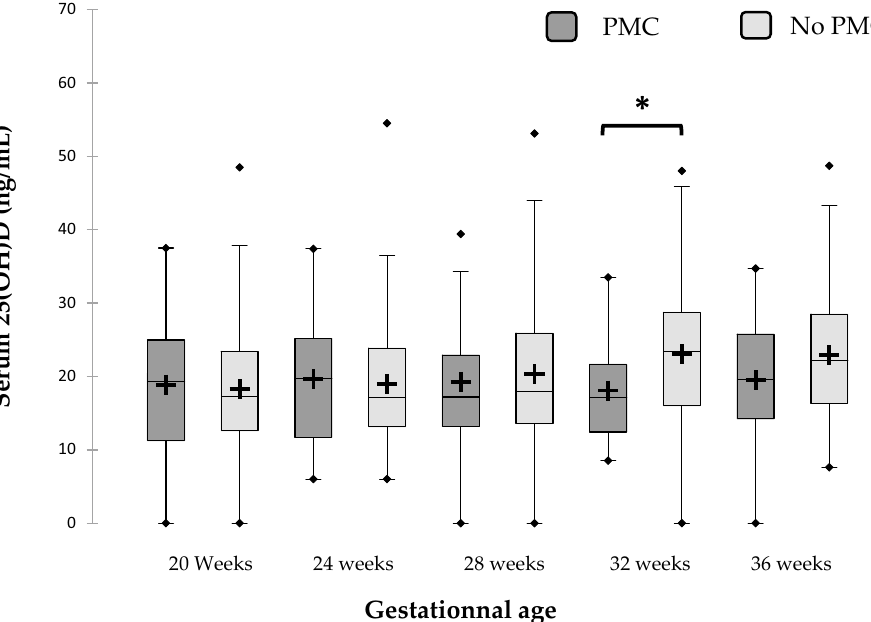
Figure 1. Evolution of the vitamin D profile during pregnancy depending on the occurrence of any PMC. The red crosses are the averages. The central horizontal bars are the medians. The lower and upper limits of the boxes are the first and third quartiles. The points are the minimum and maximum for each species. PMC placenta- mediated complication * P = 0.001.